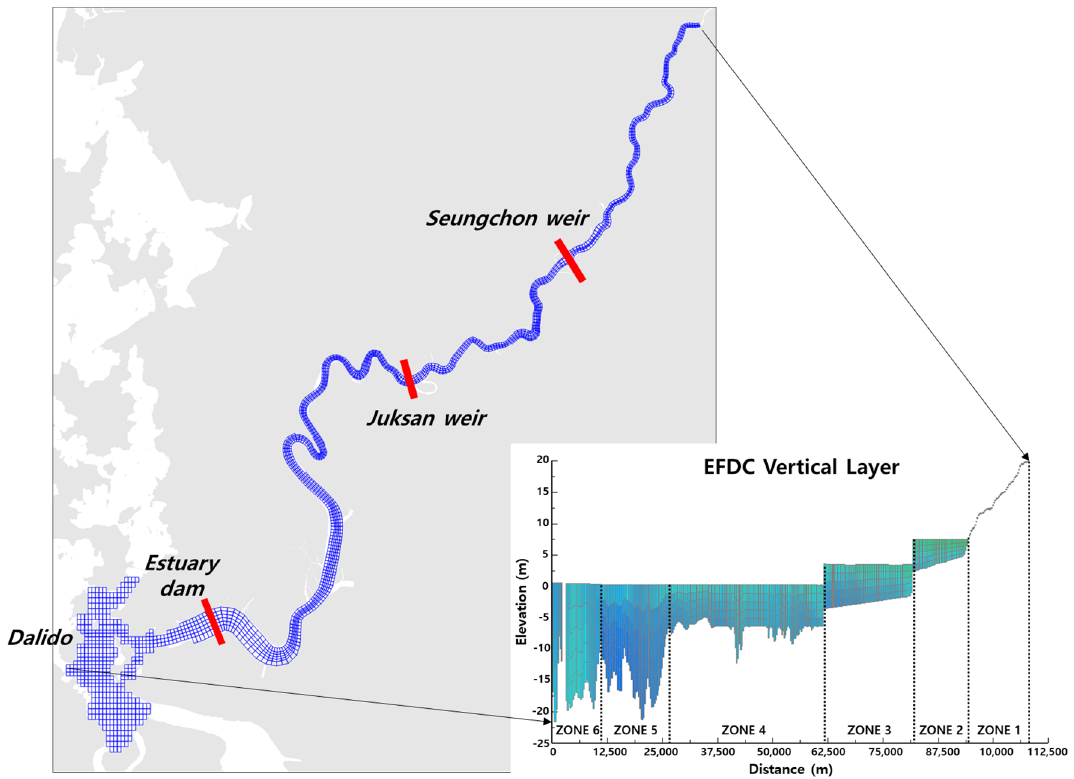
Figure 3. Grid of the Yeongsan River physical domain. Grid spacing ranges from approximately 62–510 m [12]. Table 2. Trait-separated phytoplankton functional groups in the Yeongsan River